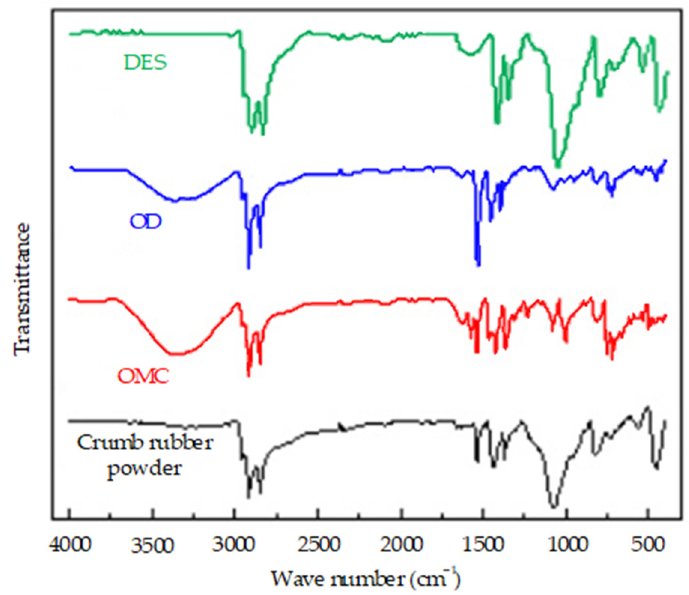
Figure 8. The infrared spectrum of the crumb rubber prepared by the chemical activation treatment method using different adjuvants.